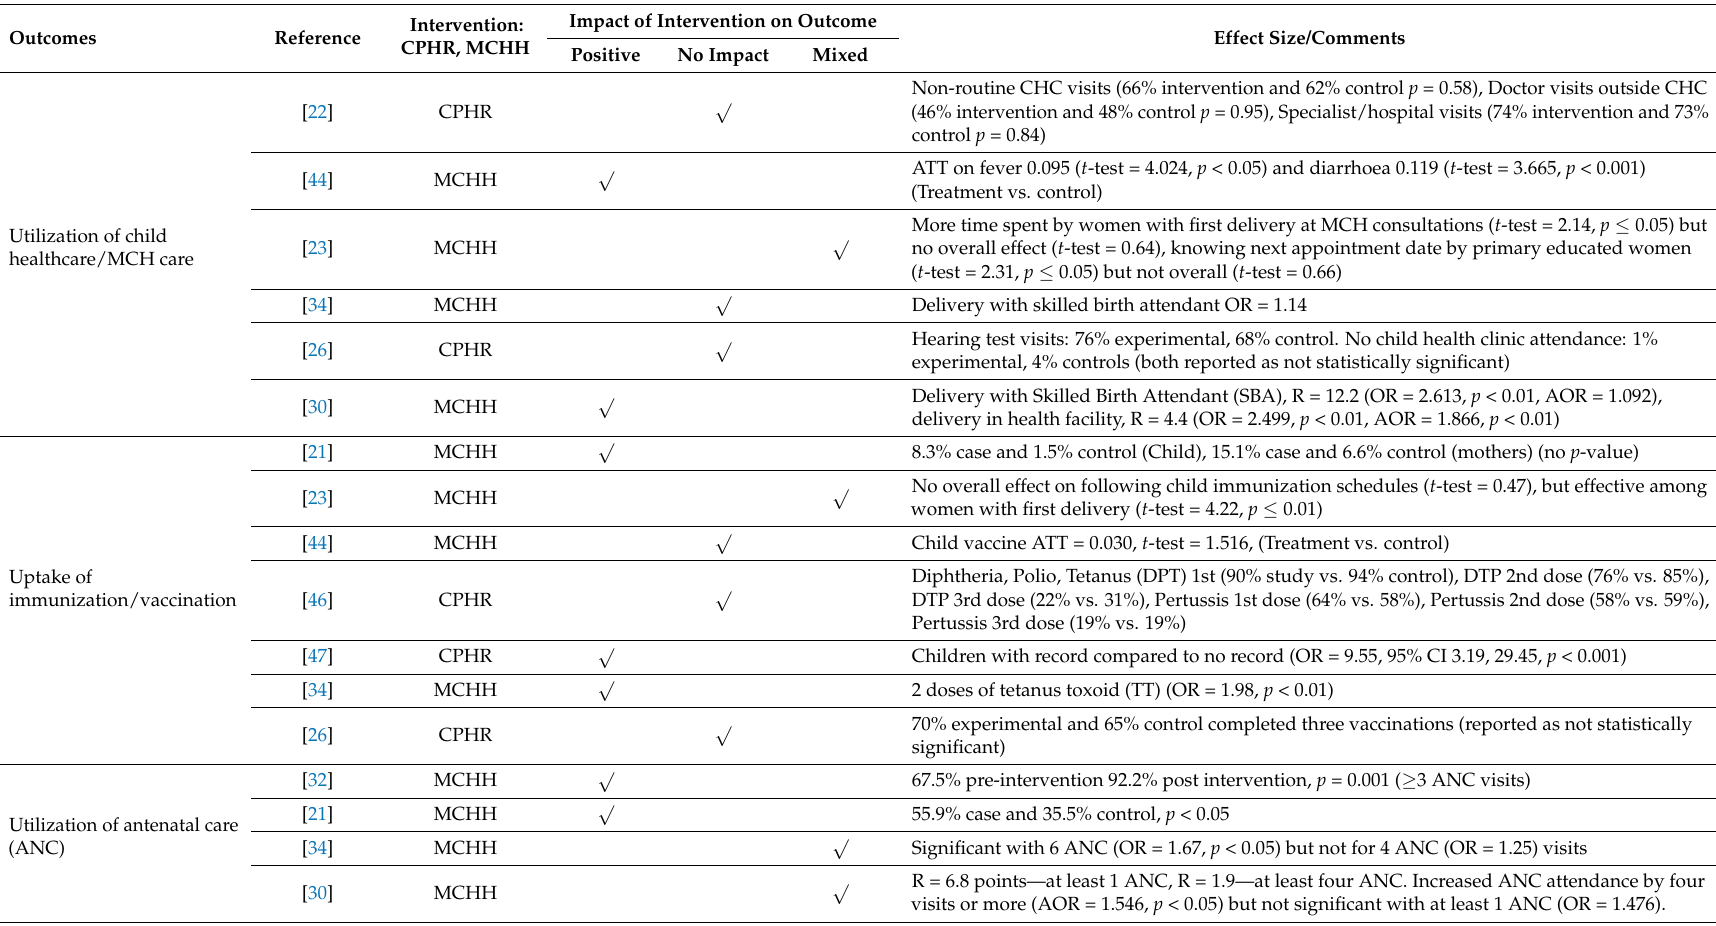
Table 2. Impact of intervention (PHCHR) on health-related